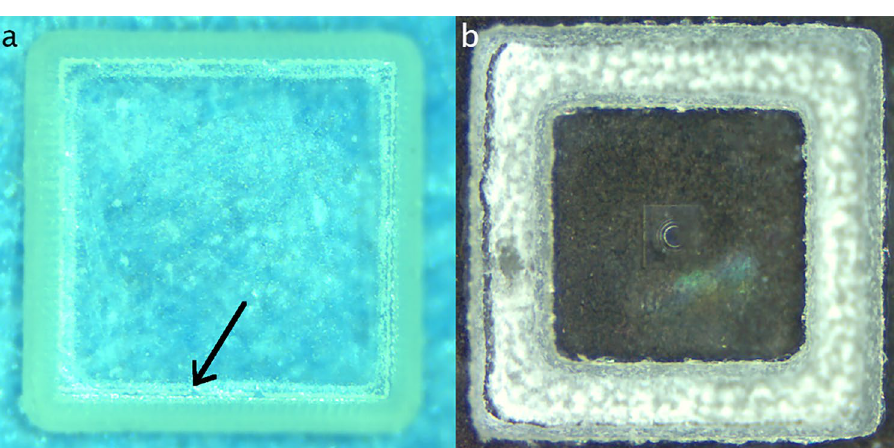
Figure 7. DOE of dimensions 225 × 225 µm on a glass square of 1.2 × 1.2 mm ( a ) with laser ablation. The black arrow points to the Ormocomp area damaged by heating during the cutting process. (B) With